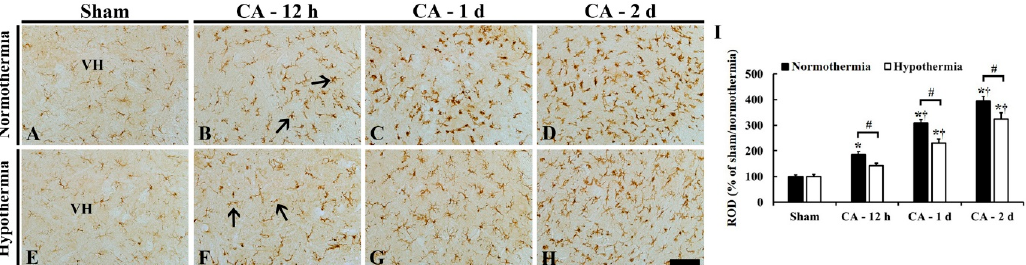
Figure 4. Iba-1 immunohistochemistry in the lumbar ventral horn of the sham/normothermia ( A ), ACA/normothermia ( B – D ), sham/hypothermia ( E ), and ACA/hypothermia ( F – H ) groups. In the ACA/normothermia group, Iba-1 immunoreactivity (arrows) is significantly increased from 12 h after ACA compared to that in the sham/normothermia group. However, in the ACA/hypothermia group, Iba-1 immunoreactivity (arrows) at 12 h after ACA is similar to that in the sham/hypothermia group; thereafter, Iba-1 immunoreactivity is significantly lower than that in the ACA/normothermia group. VH, ventral horn. Scale bar = 100 µm. ( I ) ROD as % of Iba-1 immunoreactive structures in the lumbar ventral horn. The bars indicate the means ± SEM ( n = 5 and 7 for the sham and ACA groups; * p < 0.05 vs. each sham group; # p < 0.05 vs. the ACA/normothermia group; † p < 0.05 vs. the previous time-point group).